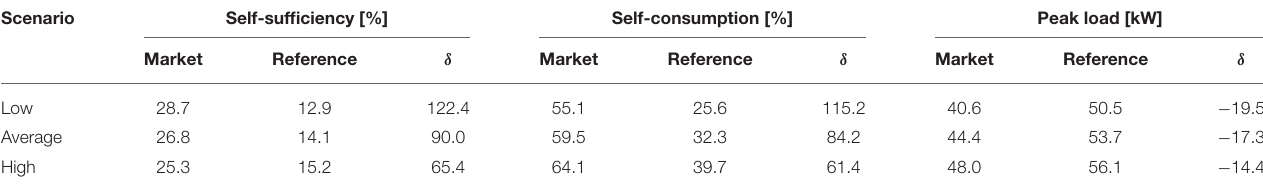
TABLE 3 | Comparison between different consumption behavior at the microgrid level.